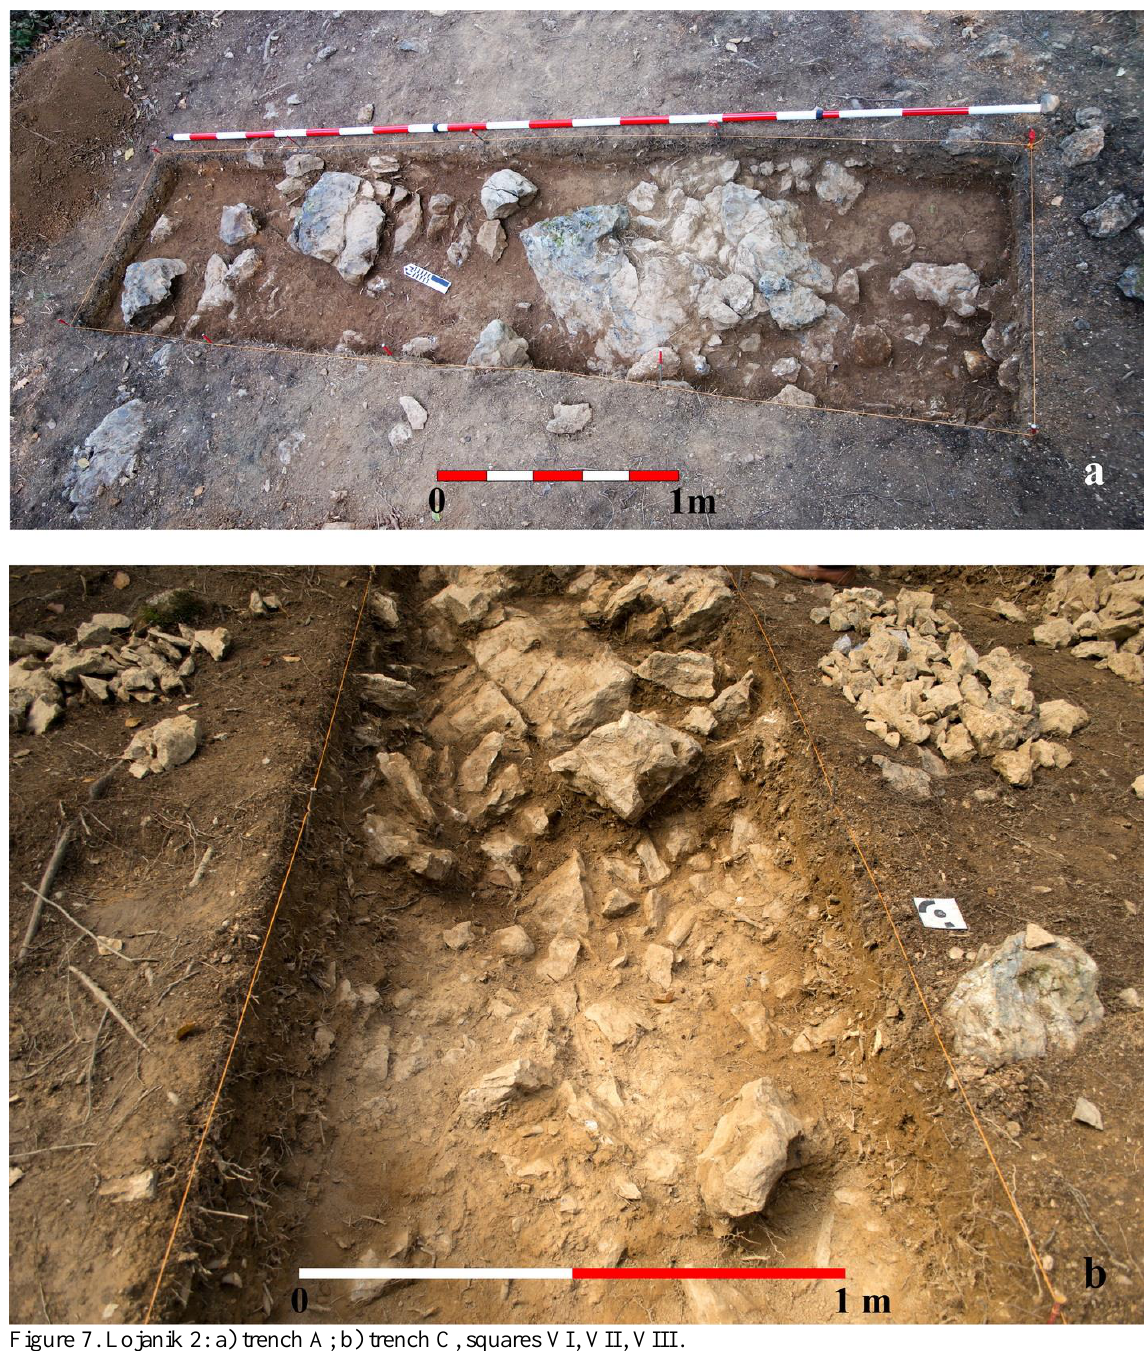
Figure 7. Lojanik 2: a) trench A; b) trench C, squares VI, VII,